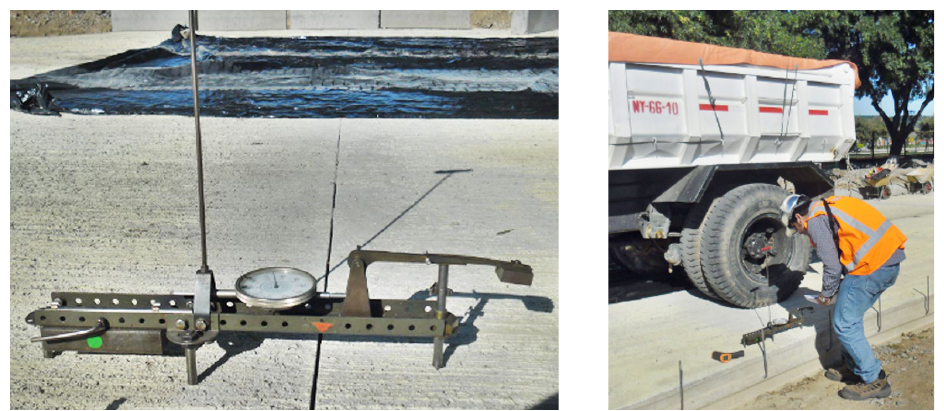
Figure 6. Measurements perfomed with the